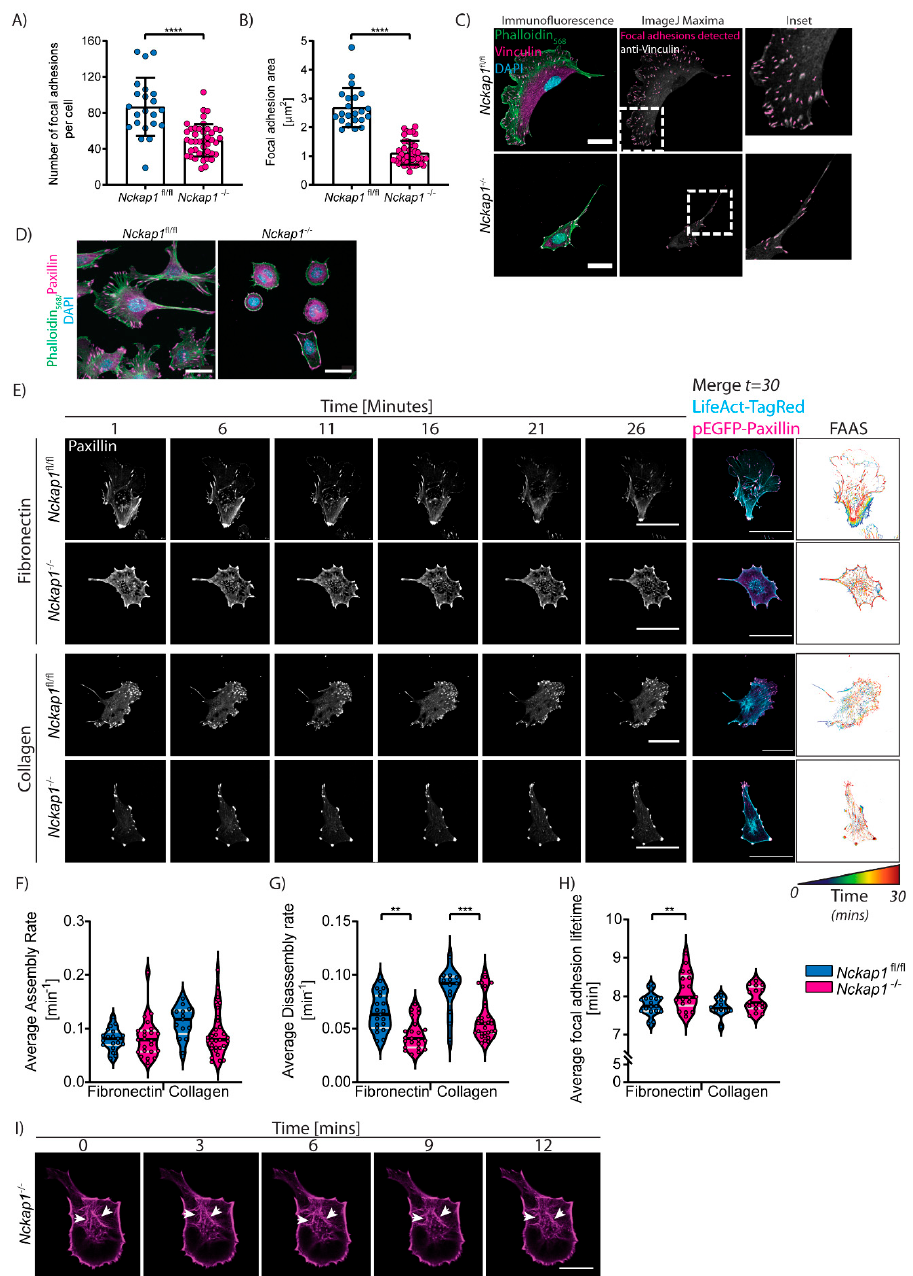
Figure 3. Loss of Nckap1 affects focal adhesion dynamics. ( A – C ) Quantification of focal adhesions in control and Nckap1 KO MEFs. ( A ) Quantification of the number of focal adhesions normalised to the cell area. ( B ) Quantification of focal adhesion area normalised to cell area. ( A , B ) n = 22 control and 42 Nckap1 KO cells analysed from 2 independent experiments. The error bars represent S.D. Statistical significance was assessed using a two-tailed t -test with Welch’s correction (Focal adhesion numbers) and a non-parametric Mann Whitney test (Average adhesion area), **** p < 0.0001. ( C ) Representative images of control and Nckap1 KO cells stained with Phalloidin, Vinculin (focal adhesion marker)